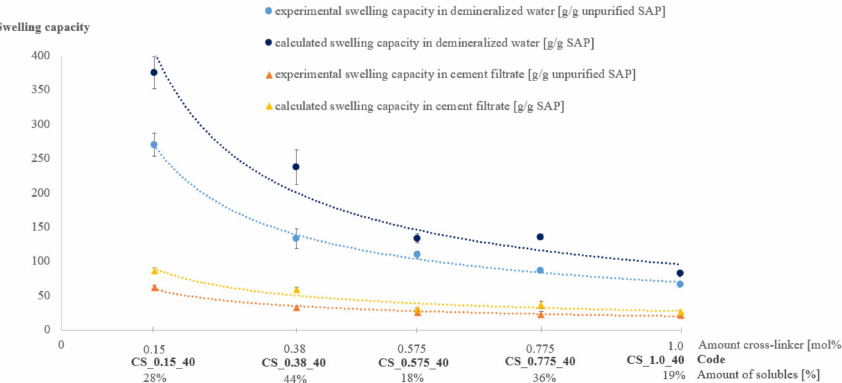
Figure 1. Characterization of superabsorbent polymers (SAPs): amount of solubles, experimental [g / g unpurified SAP] and calculated [g / g SAP] swelling capacity in demineralized water and cement filtrate solution (n = 3), Series